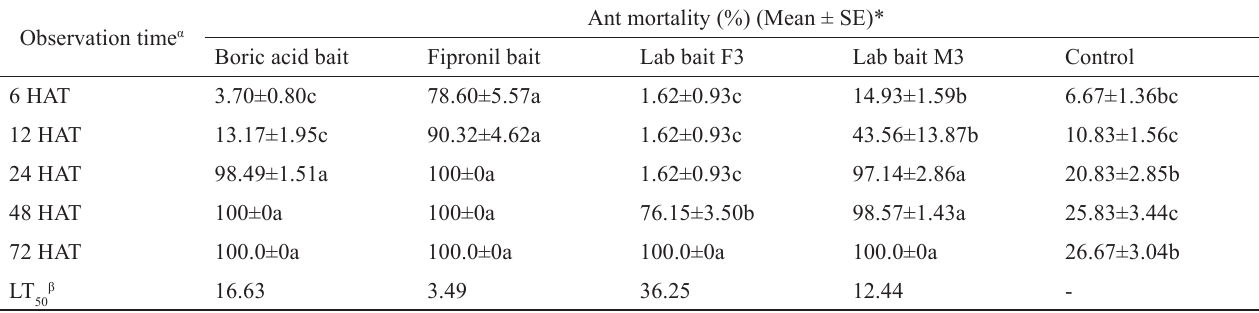
At 24 HAT, the percentage of ants killed by the fipronil bait was significantly higher than the other three baits tested. However, the percentage of ants killed by the boric acid, fipronil and the lab bait F3 were not significant different (F = 600.52, p < 0.01) (Table 5). Similarly, at 48 HAT, the Table 5 . Mortality of A. gracilipes by lab baits F3and M3 against two commercial baits under laboratory conditions.